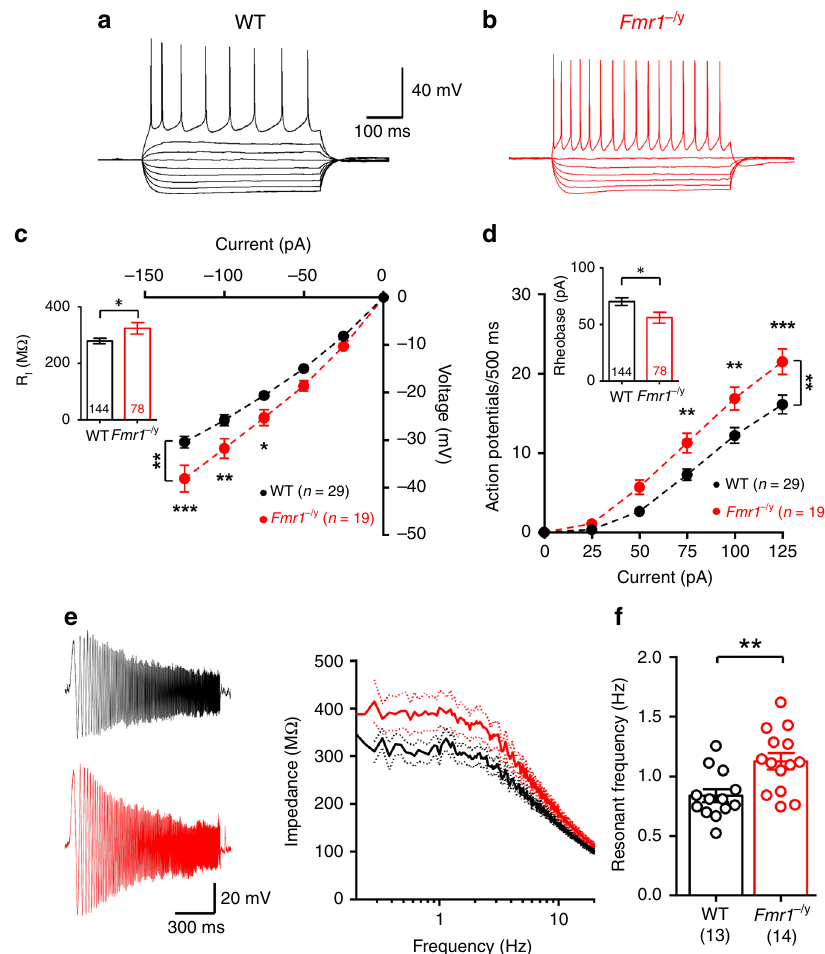
Fig. 6 Altered intrinsic physiology of L4 SCs in Fmr1 − /y mice. Voltage responses to hyper- and depolarizing current steps ( − 125 to + 125pA, 25pA steps, 500 ms duration) led to AP discharge in WT ( a ) and Fmr1 − /y ( b ) mice. c The current – voltage response to hyperpolarizing currents with linear fi t (dashed lines) in WT (black) and Fmr1 − /y (red) mice. c (inset) R I measured from all L4 SCs tested. d Current – frequency plot showing AP discharge. d (inset) Average rheobase current measured in all cells. e Subthreshold membrane chirps (0.2 – 20Hz, 50pA, 20s duration) in L4 SCs from WT (black) and Fmr1 − /y mice. Right, frequency – impedance plot for both genotypes±SEM, shown on a logarithmic frequency scale. f Resonant frequency of L4 SCs from both genotypes. Statistics shown: * p <0.05, ** p <0.01, *** p ±<0.001, from LMM ( c and d insets, f ) and two-way ANOVA ( c and d , main). Summary plots of all cells recorded for c (inset) and d (inset) can be found in Supplementary Fig. 5. All data are shown as mean±SEM and source data for all plots are provided as a Source Data fi